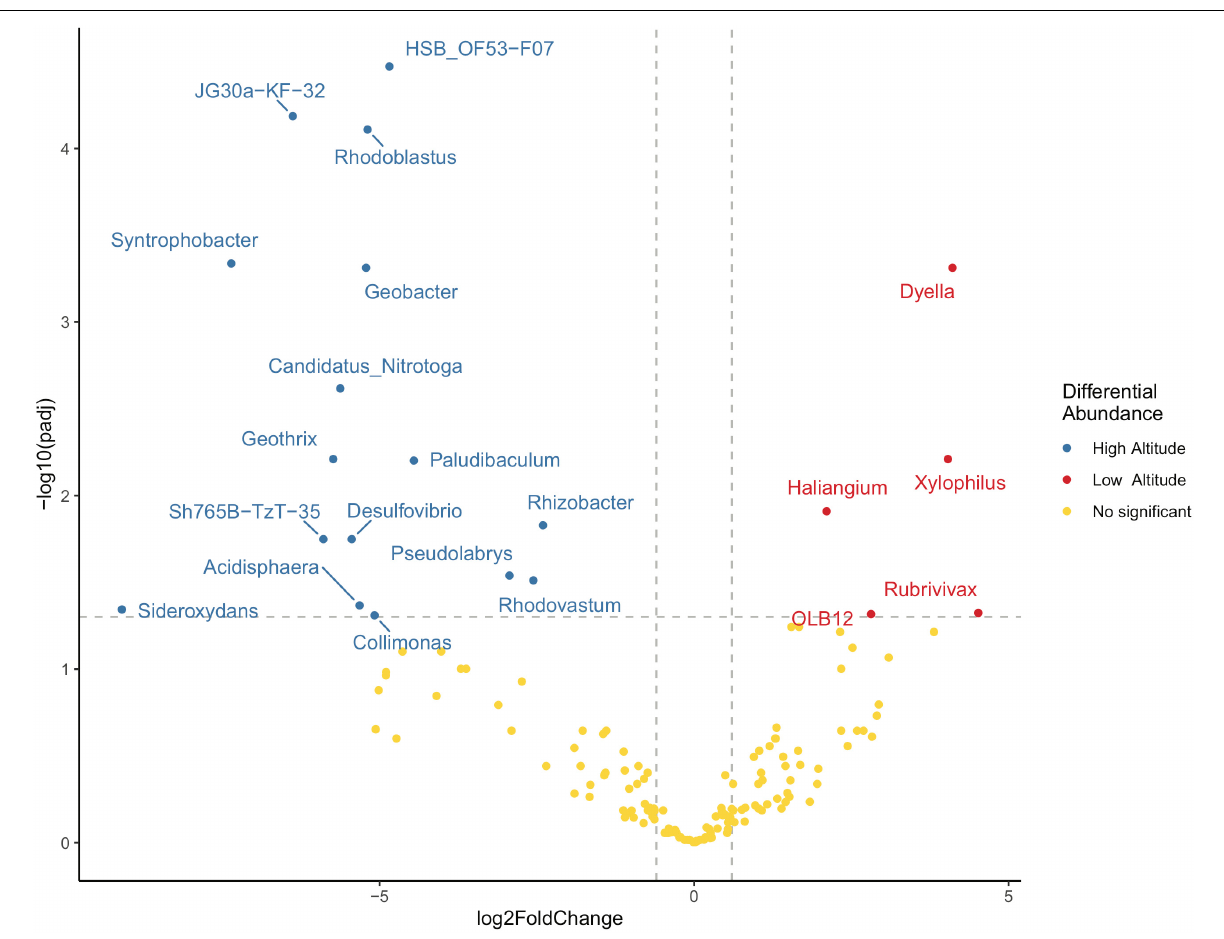
FIGURE 7 | Volcano plot of the differential genera analysis for soil samples. The cutoff to minimize the false discovery rate was set at p adj < 0.05 and | log2fc| > 0.6. Samples to the left are significantly more abundant at higher elevations, to the right at lower elevations. To improve the visualization of the results, unclassified taxa at the genus level were